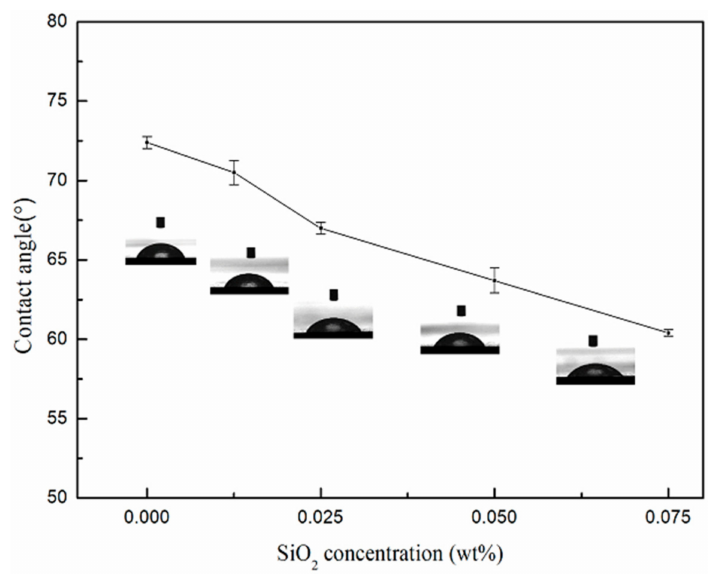
Figure 3. Contact angles of PSf/PA and PSf/PA-SiO 2